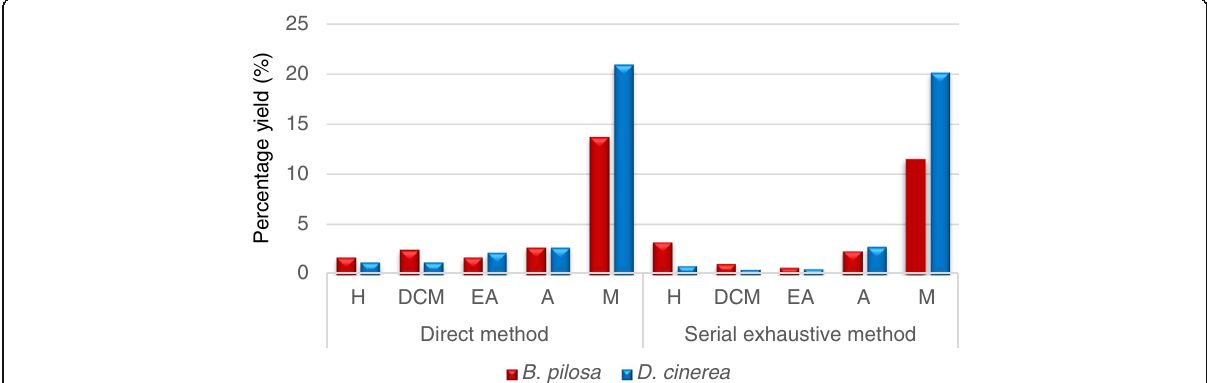
Fig. 1 The percentage yield of B. pilosa and D. cinerea leaf extracts following extraction using the direct and serial exhaustive extraction methods. H, hexane; DCM, dichloromethane; EA, ethyl acetate; A, acetone; M, methanol